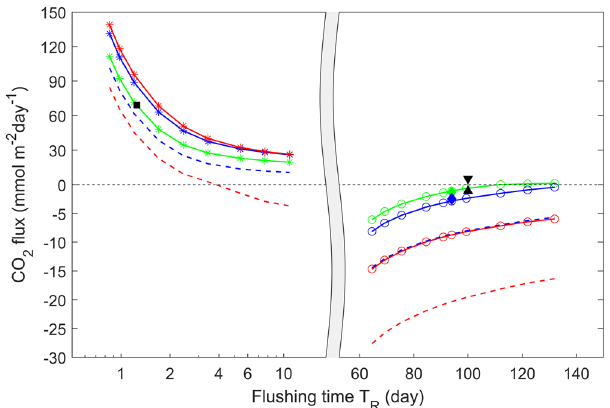
Fig. 5 A regime diagram for estuarine response to higher atmospheric CO 2 in two different types of estuaries. Air-sea CO 2 fl ux versus fl ushing time T R at the atmospheric p CO 2 = 400 (green), 550 (blue), and 800 (red) ppm, obtained from a box model of a generic estuary. The circles on the right half of the diagram represent large estuaries with T R = (2 – 5) months and the stars on the left half represent small estuaries with T R = (1 – 10) days. The black upper and low triangles represent observational estimates from Chesapeake Bay by Friedman et al. 15 and Chen et al. 24 The black square represents the observational estimates from the Altamaha River by Cai and Wang 34 and Jiang et al. 35 The green and blue diamonds are the air- sea fl ux for the late-20th (Run Hist) and mid-21st century (Run Fut1) calculated from the 3D model of Chesapeake Bay. The solid blue and red lines represent model runs in which shelf water p CO 2 increases at 50% of the rate of atmospheric p CO 2 (Runs Fut1) while the dashed lines represent model runs in which shelf water p CO 2 does not change (Runs